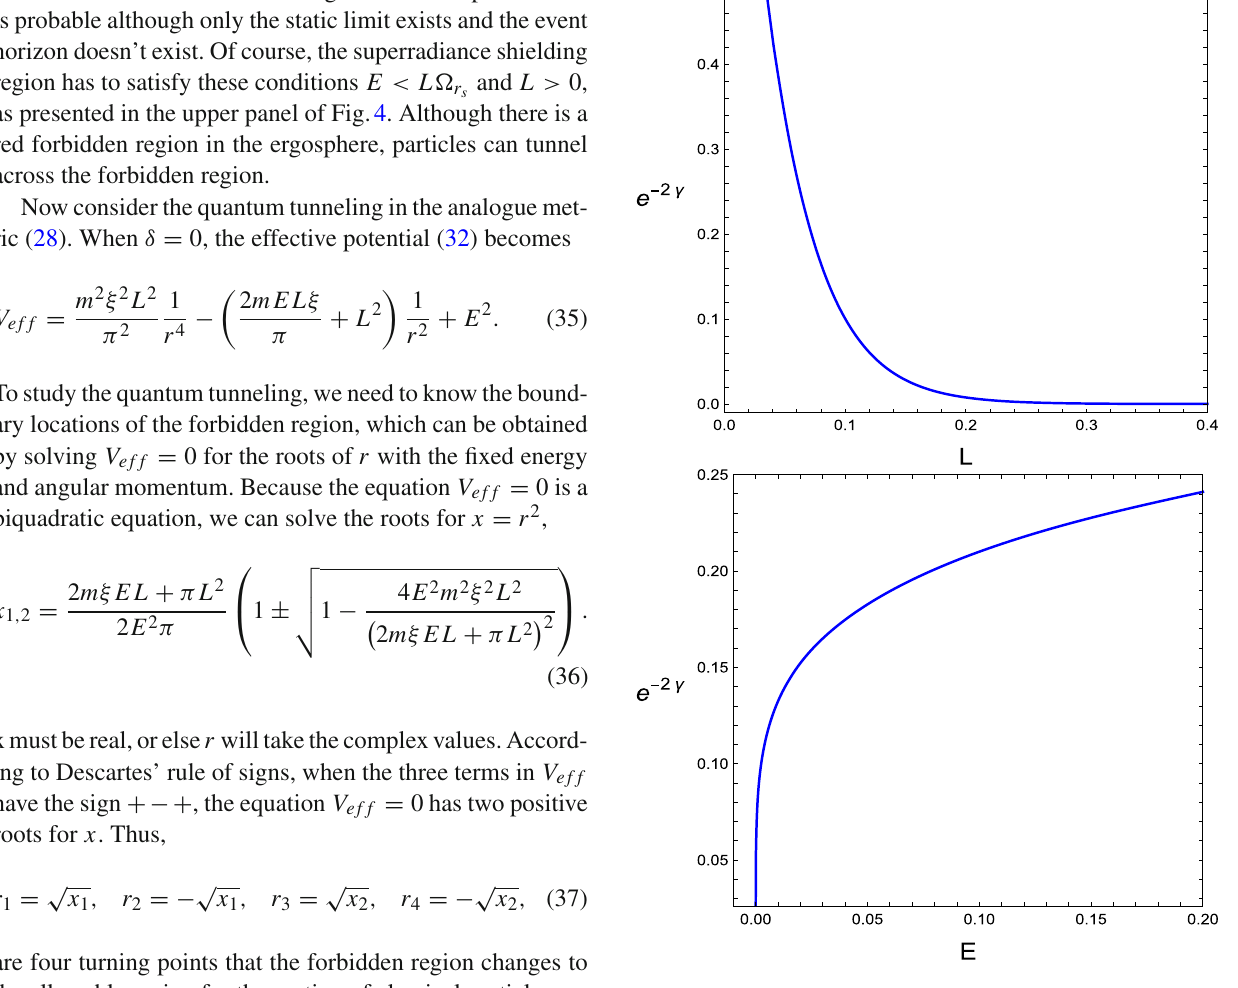
Fig. 5 Gamow factor as the function of angular momentum with the energy E = 0 . 00252 in the upper panel and as the function of energy with the angular momentum L = 0 .